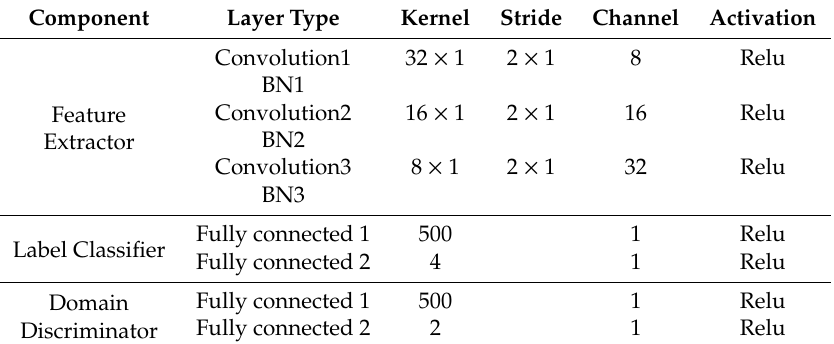
Table 3. Details of the networks used in this